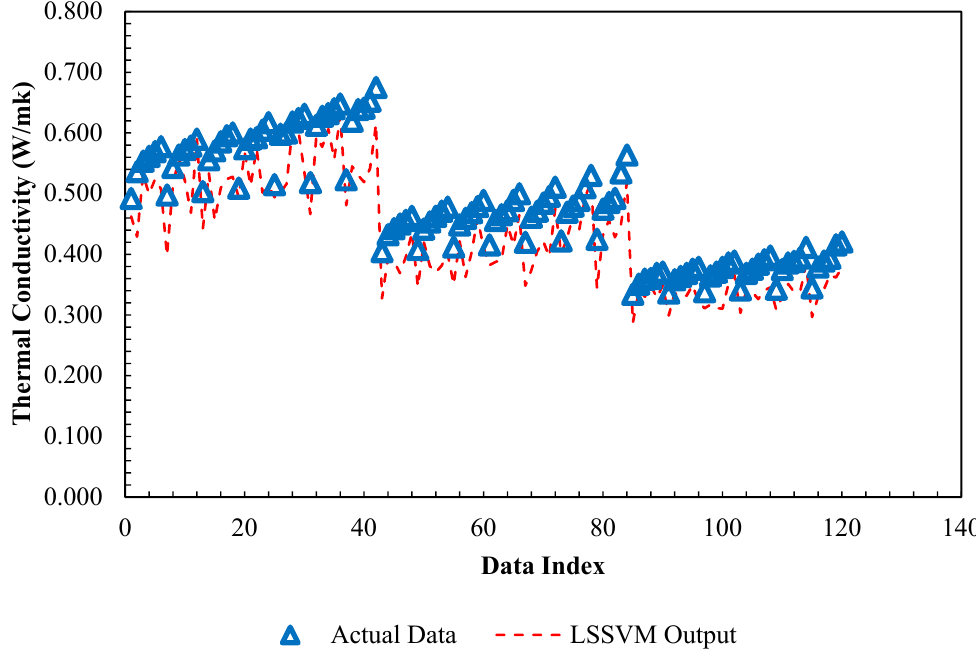
Figure 21. Comparison between actual thermal conductivity of Fe 2 O 3 /ethylene glycol-water nanofluid and predicted values by PSO-ANN model versus relevant data index.